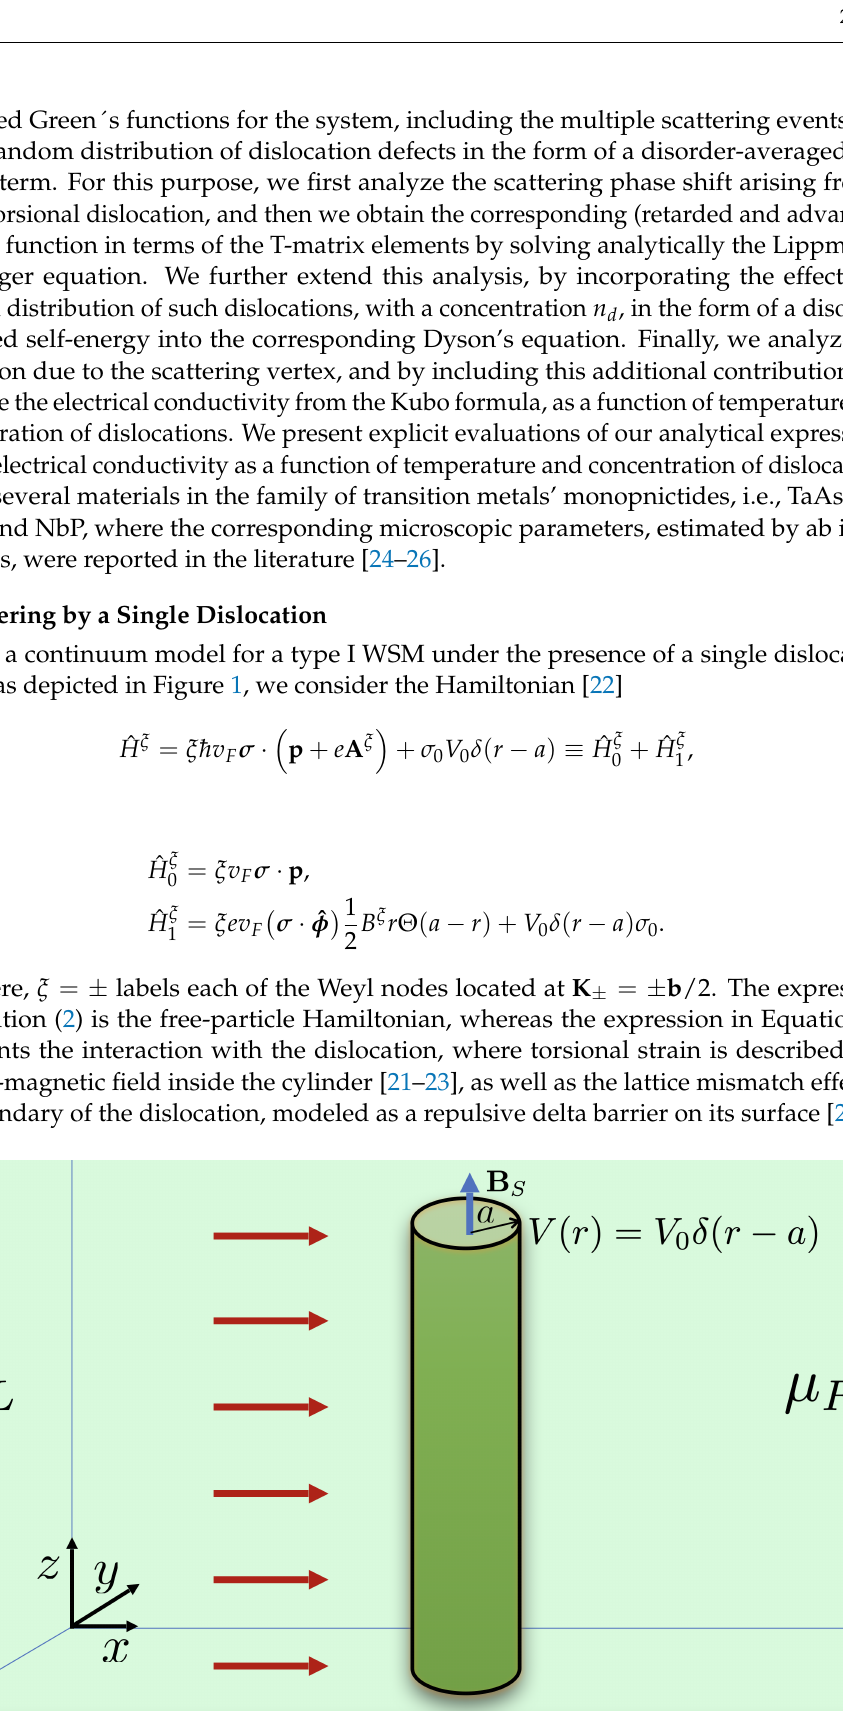
Figure 1. Pictorial description of the scattering of free incident Weyl fermions coming from a left reservoir by a single cylindrical dislocation